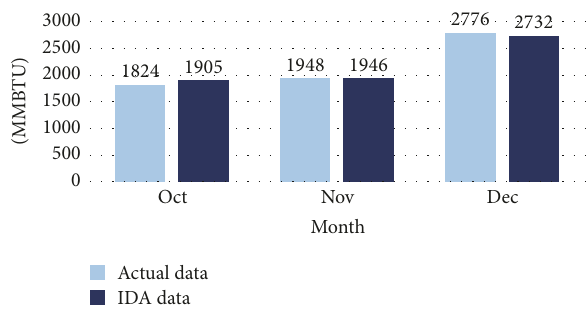
Figure7:DifferencebetweenhotwaterpowerusageofIDAICEand actual